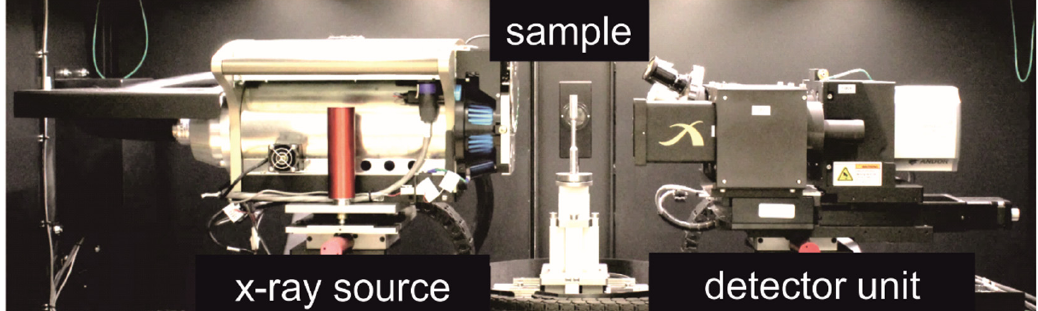
Figure 5. Measuring unit of the µ-CT Xradia 520 versa [22].